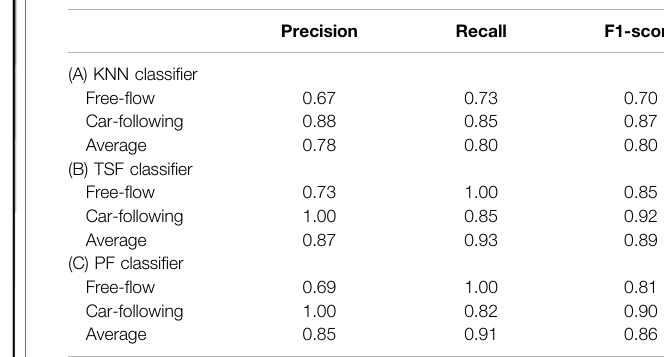
TABLE 2 | Classifying Humans ’ Free- fl ow and Car-following Braking Behavior using Univariate Time Series Classi fi ers: (A) KNN, (B) TSF, and (C) PF Classi fi ers.